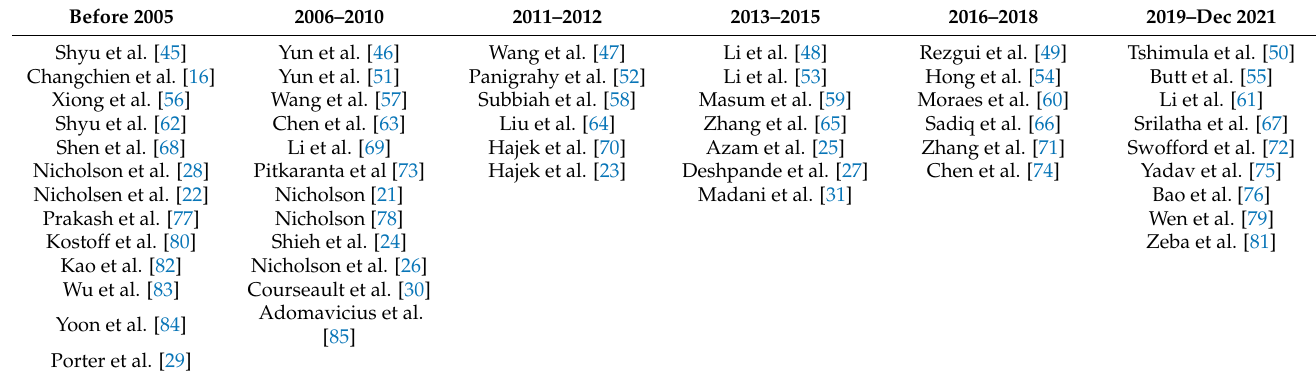
Table 2. Time distributions of the papers considered for